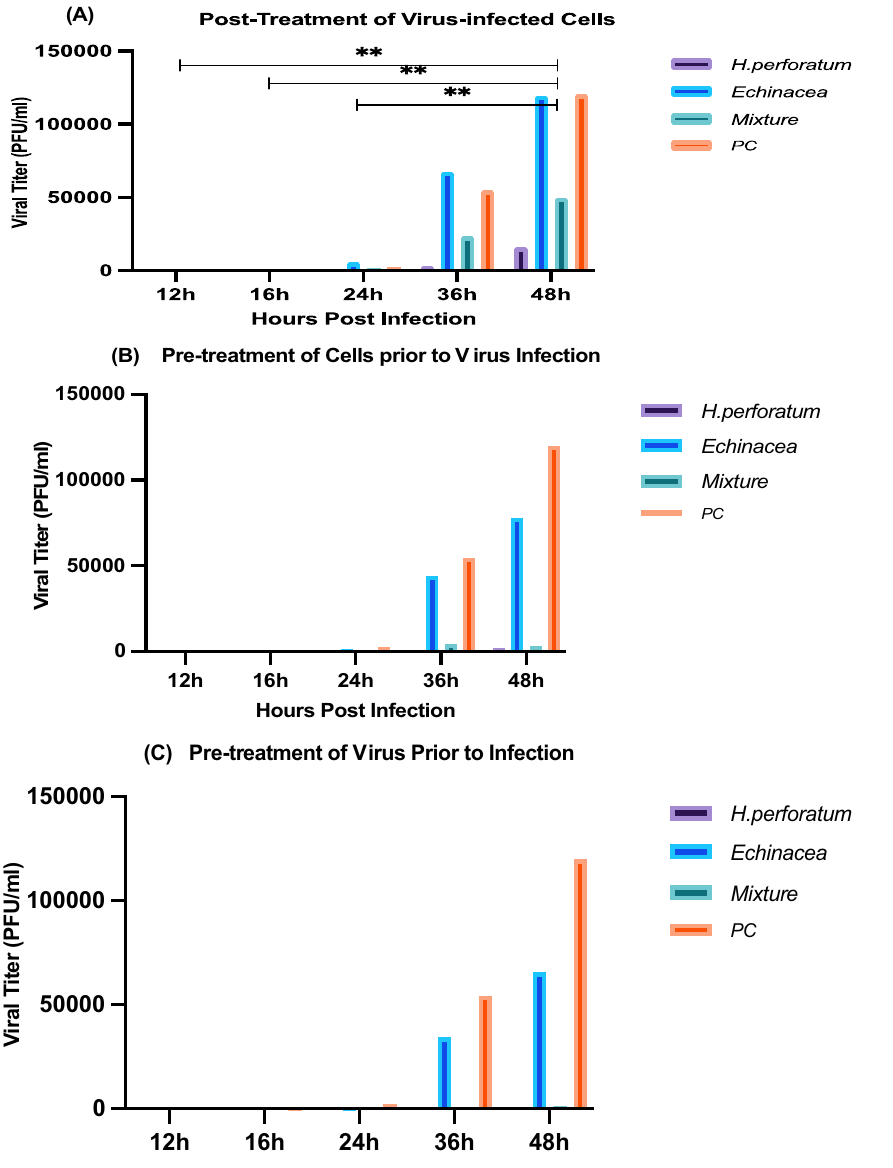
Figure 3. The effect of H. perforatum , Echinacea , and H. perforatum-Echinacea mixture on viral load of SARS- CoV-2 infection in Vero E6 cells was evaluated by qRT-PCR. The three experimental designs: post treatment of virus-infected cells ( A ), pre-treatment of cells prior to virus infection ( B ), and virucidal ( C ) assays. Comparing to the viral control, the viral load of H. perforatum was less than 25,000 PFU/mL up to 48 h in ( A ) and almost zero in ( B ) and ( C ), while it was less than 50,000 PFU/mL for the H. perforatum-Echinacea mixture, and it showed the most viral load with Echinacea up to 36 h. The viral load was representatives of two independent experiments performed in triplicate. Statistical analysis showed that differences were significant with p < 0.005 (one- & two-way ANOVA), PC is a positive virus control where no treatment is